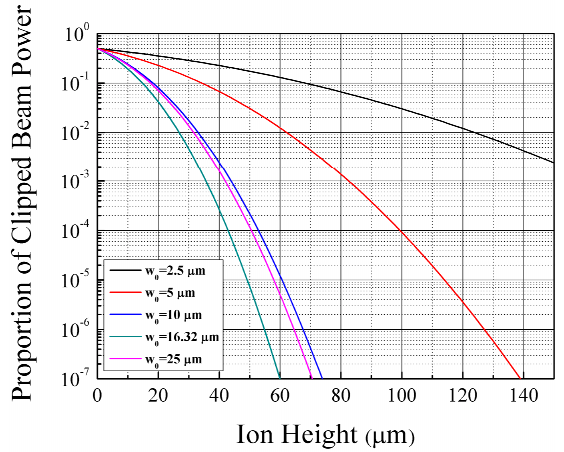
Figure 8. Proportion of the clipped beam power fraction as a function of ion height. For the calculation, we assume a laser with a wavelength of 369.5 nm, which is used in Doppler cooling and state detection of the 171 Yb + ion.